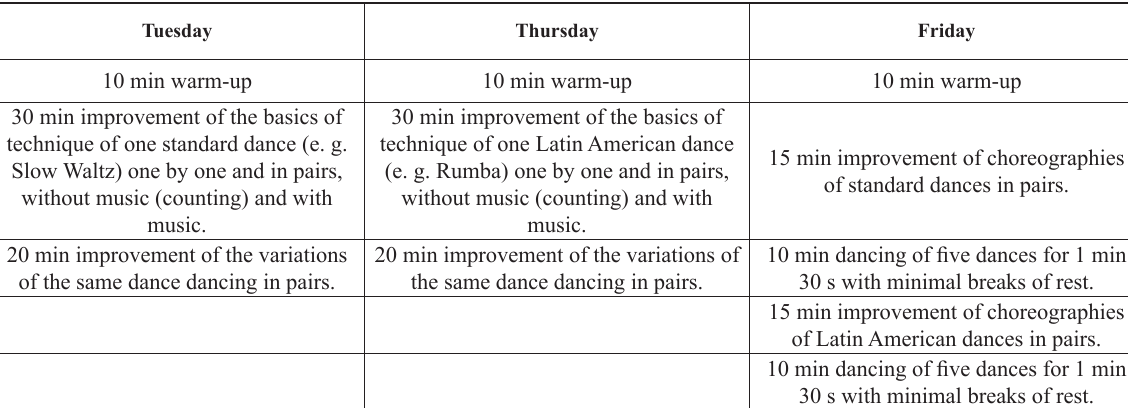
Table 2. The model of a weekly micro-cycle of practice sessions for basic special training